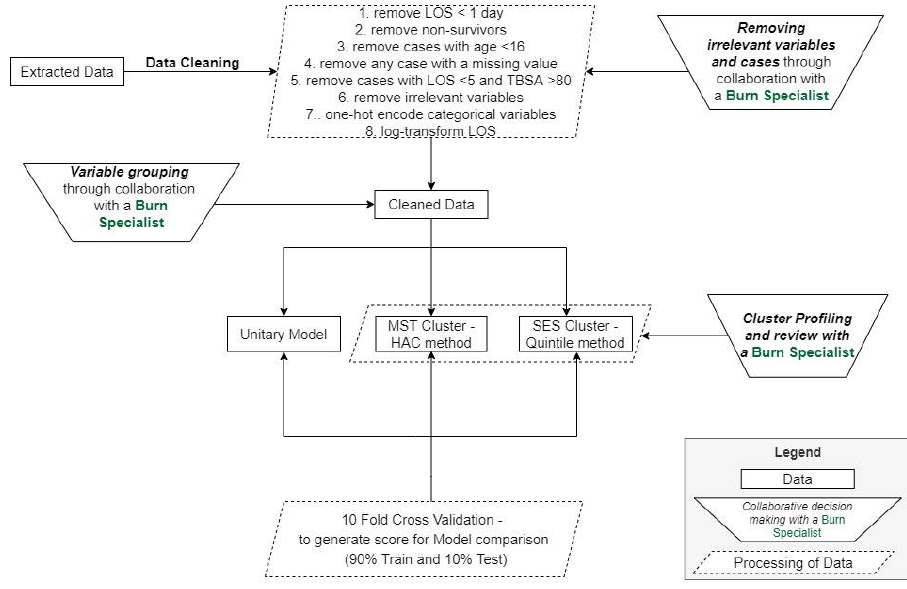
Figure 2. Analytical pipeline showing data cleaning/preprocessing to model deployment and test- ing.